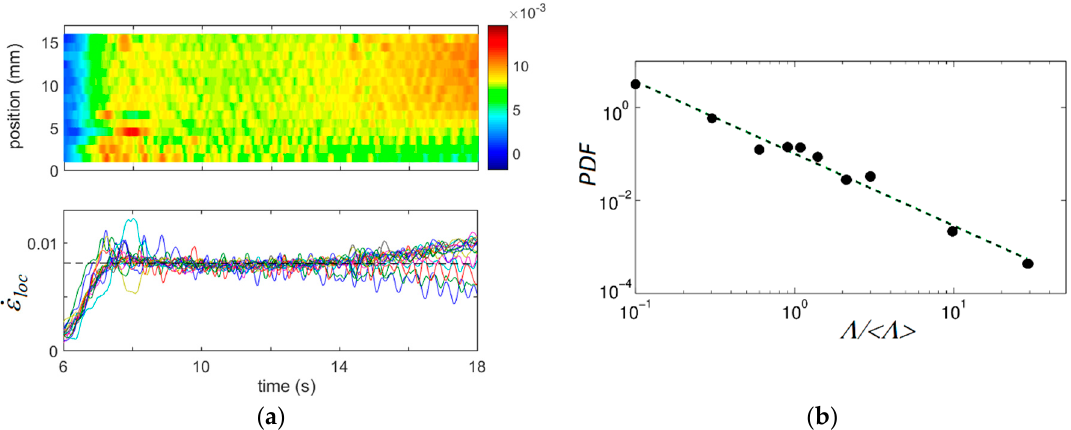
Figure 6. ( a ) Spatiotemporal pattern ε loc ( x , t ) (top) and the corresponding family of ε loc ( t ) -curves measured at various positions along the centerline of a TD specimen (bottom); ( b ) the corresponding statistical distribution of the normalized amplitudes Λ of fluctuations for one of these curves. The horizontal dashed line indicates the imposed strain rate, = 8 × 10 − 3 s − 1 .